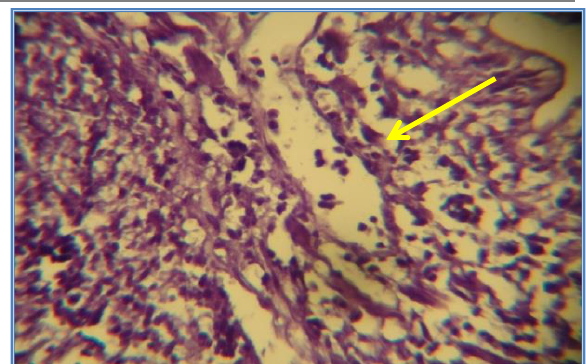
Figure, 1: Cecal tonsil of1 st group after 48hr heat exposure shows moderate mononuclear cells infiltration in the subepithelial layer (H and E stain 400X).